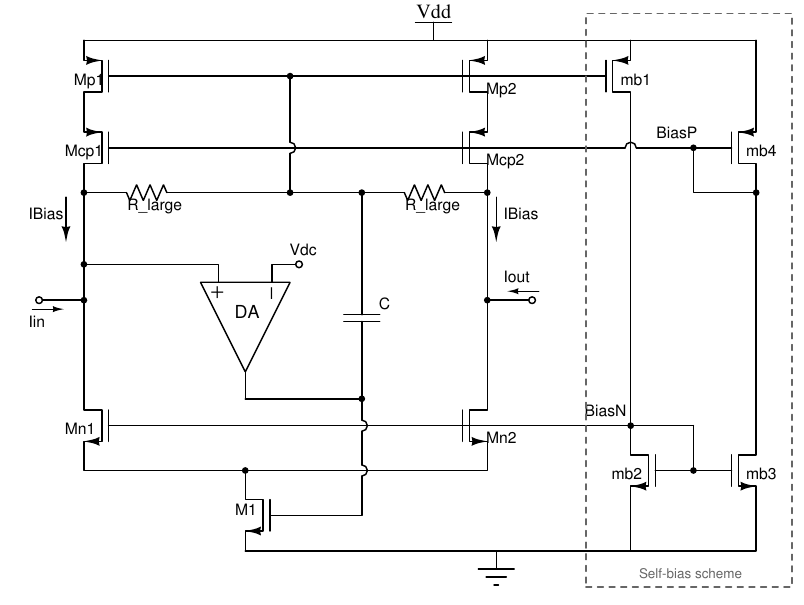
Figure 2. Proposed Self-Biased Current Buffer